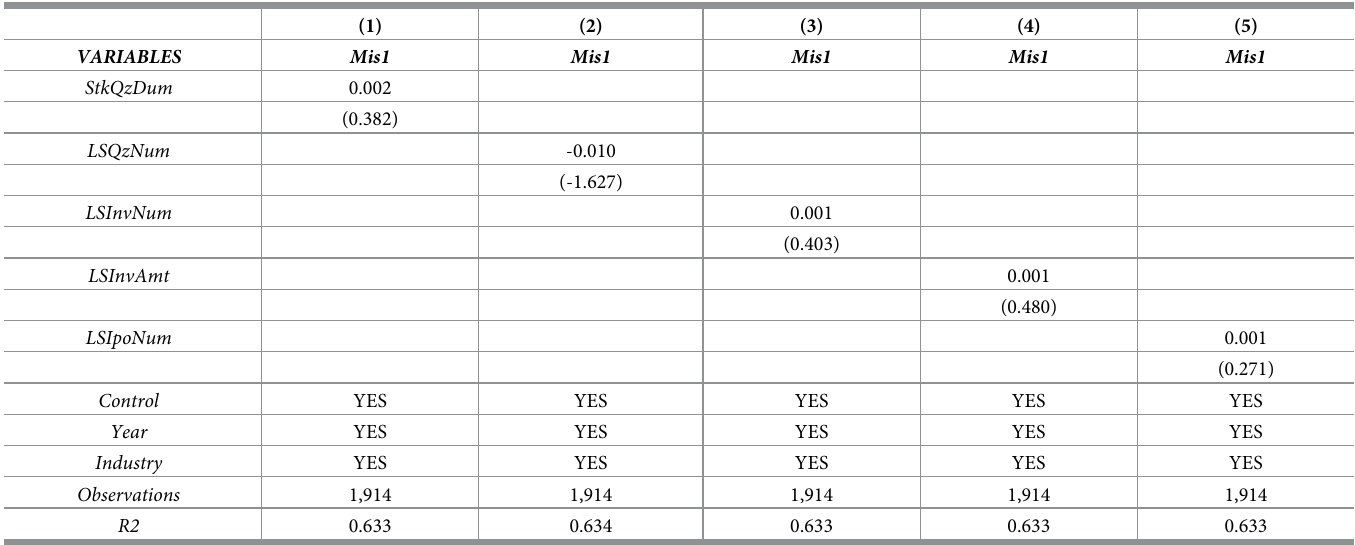
Table 16. VC Quan Zi and asset mispricing (negative)—Adding other control variables.